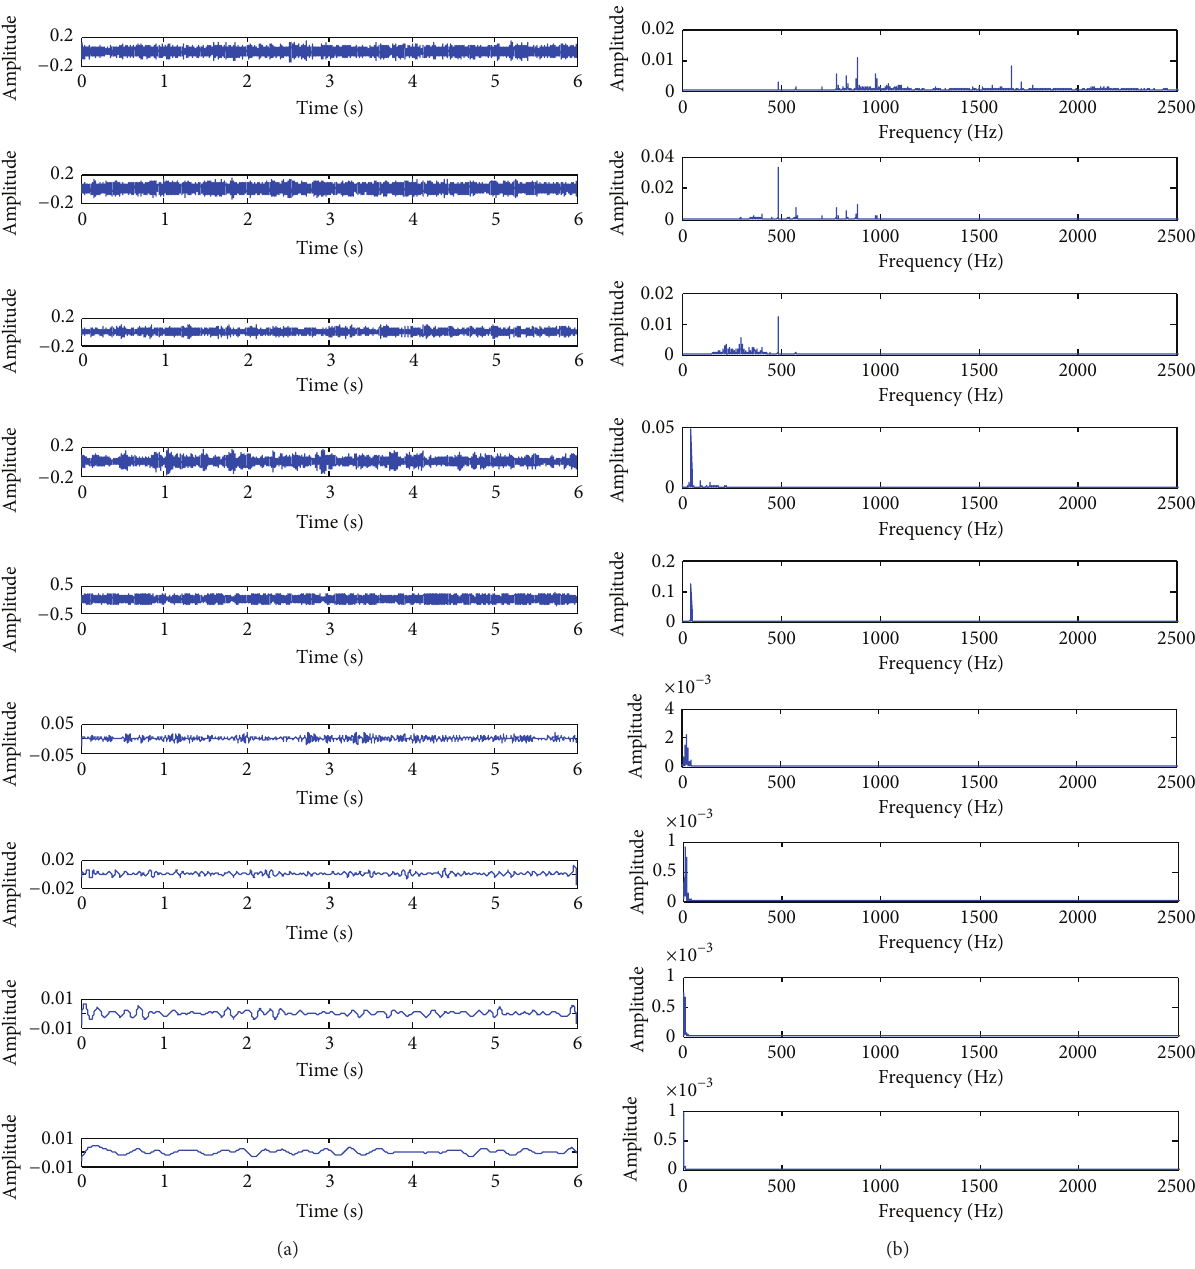
Figure 18: Results of the EEMD method under 16 mm crack condition: (a) IMFs and (b) frequency spectra of the